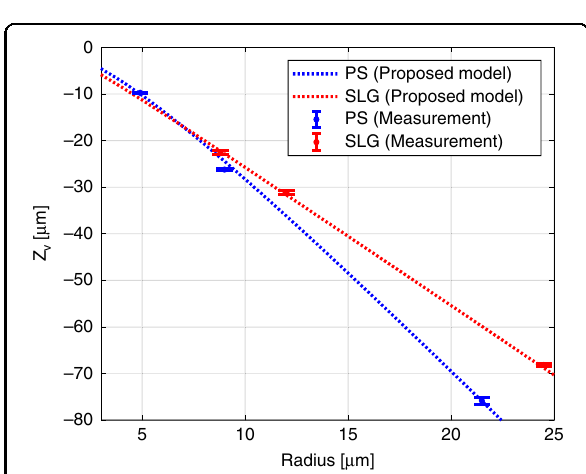
Fig. 5 Z v obtained from the actual measurement and Z v exp obtained from the proposed geometric model. Note that, Z v and Z v represent the relative positions of the virtual image from the sample. Two different materials were evaluated. The red-dashed line and error bars represent the SLG ( n = 1.52 and λ = 524 nm) microspheres with radii of 8.8, 12.0, and 24.5 μ m, and the blue dashed line and error bars represent the PS ( n = 1.60 and λ = 524 nm) microspheres with radii of 4.9, 9.0, and 24.5 μ m. The evaluated microspheres were commercial products from Cospheric